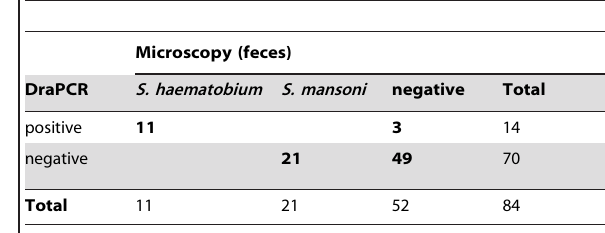
Table 2. Evaluation of the draPCR on urine samples. Table 3. Evaluation of the draPCR on